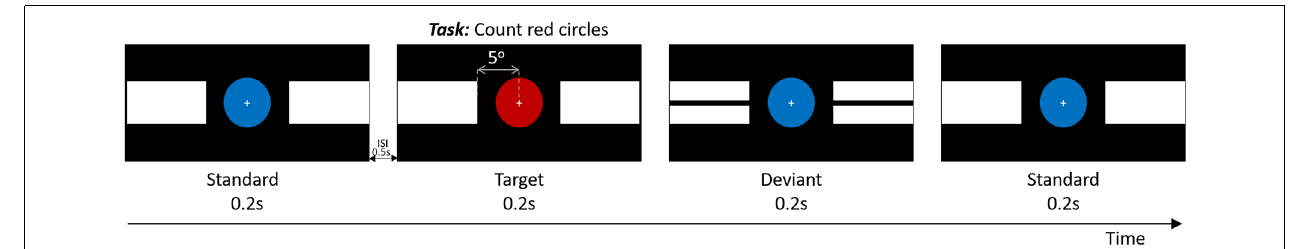
FIGURE 1 | Schematic rendition of experimental paradigm. Timing is in seconds. ISI = interstimulus